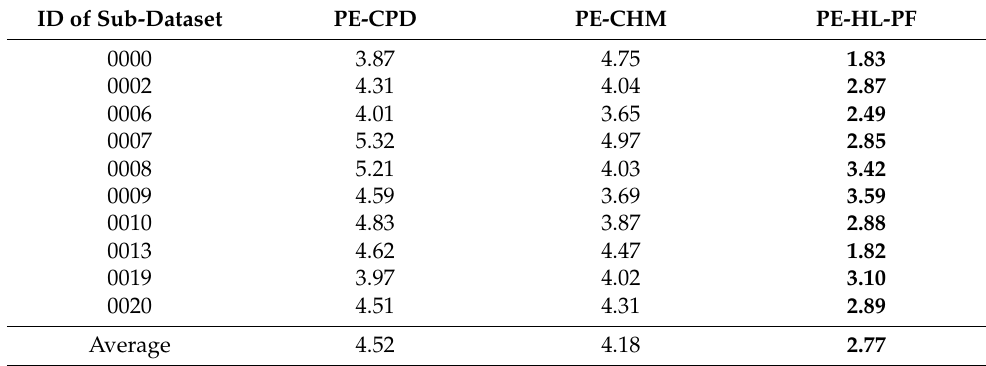
Table 2. Comparison of the mean orientation errors with ground truth object (deg). ID of Sub-Dataset